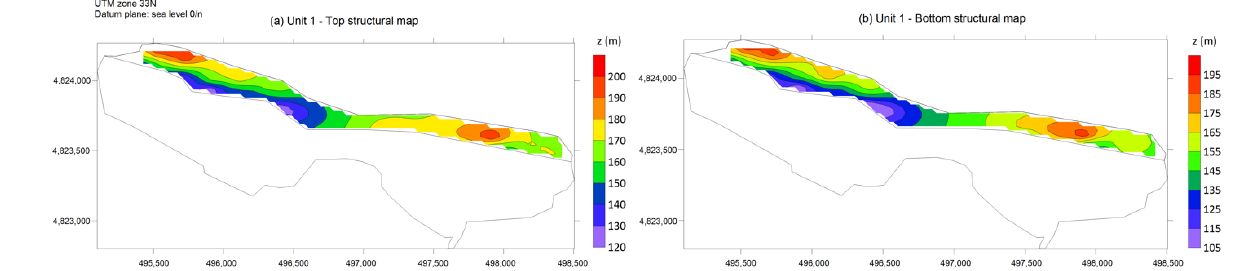
Figure 6. Top and bottom interpolation maps of the unit 1. ( a ): top, ( b ): bottom.